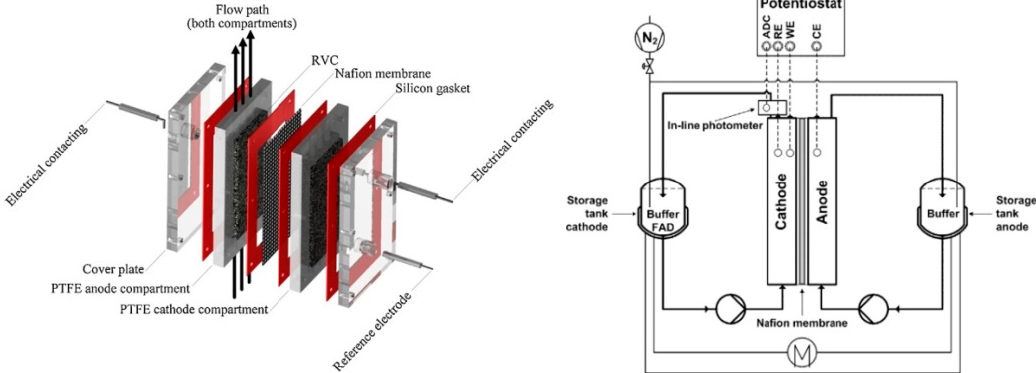
Figure 7. Schematic diagram of system for a reactor for the regeneration of FAD. Reprinted from [144] Copyright (2020), with permission from Elsevier.